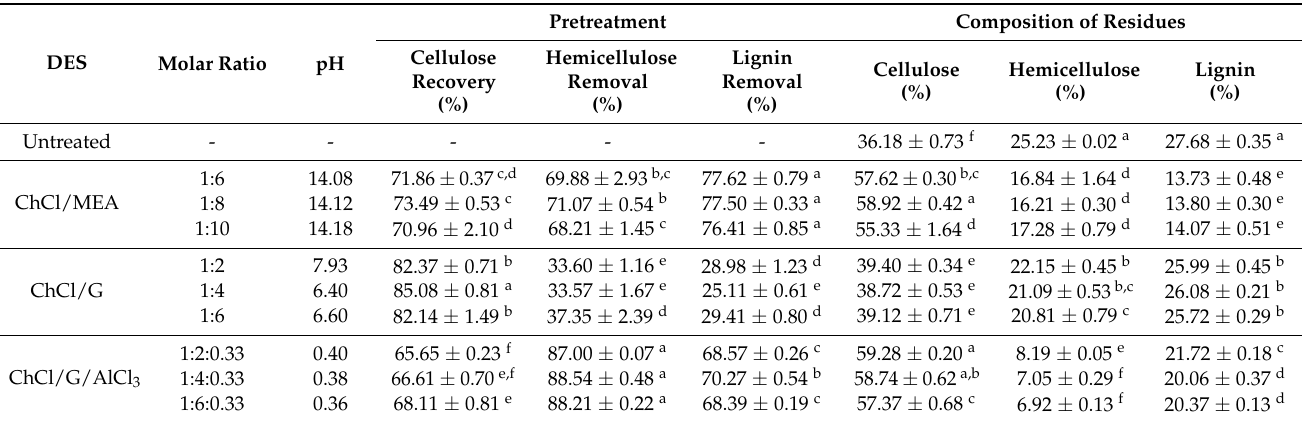
Table 1. Effects of DES types and molar ratio on the pretreatment of sugarcane leaves at a 1:16 substrate to DES solution ratio, 6 h, and 80 ◦